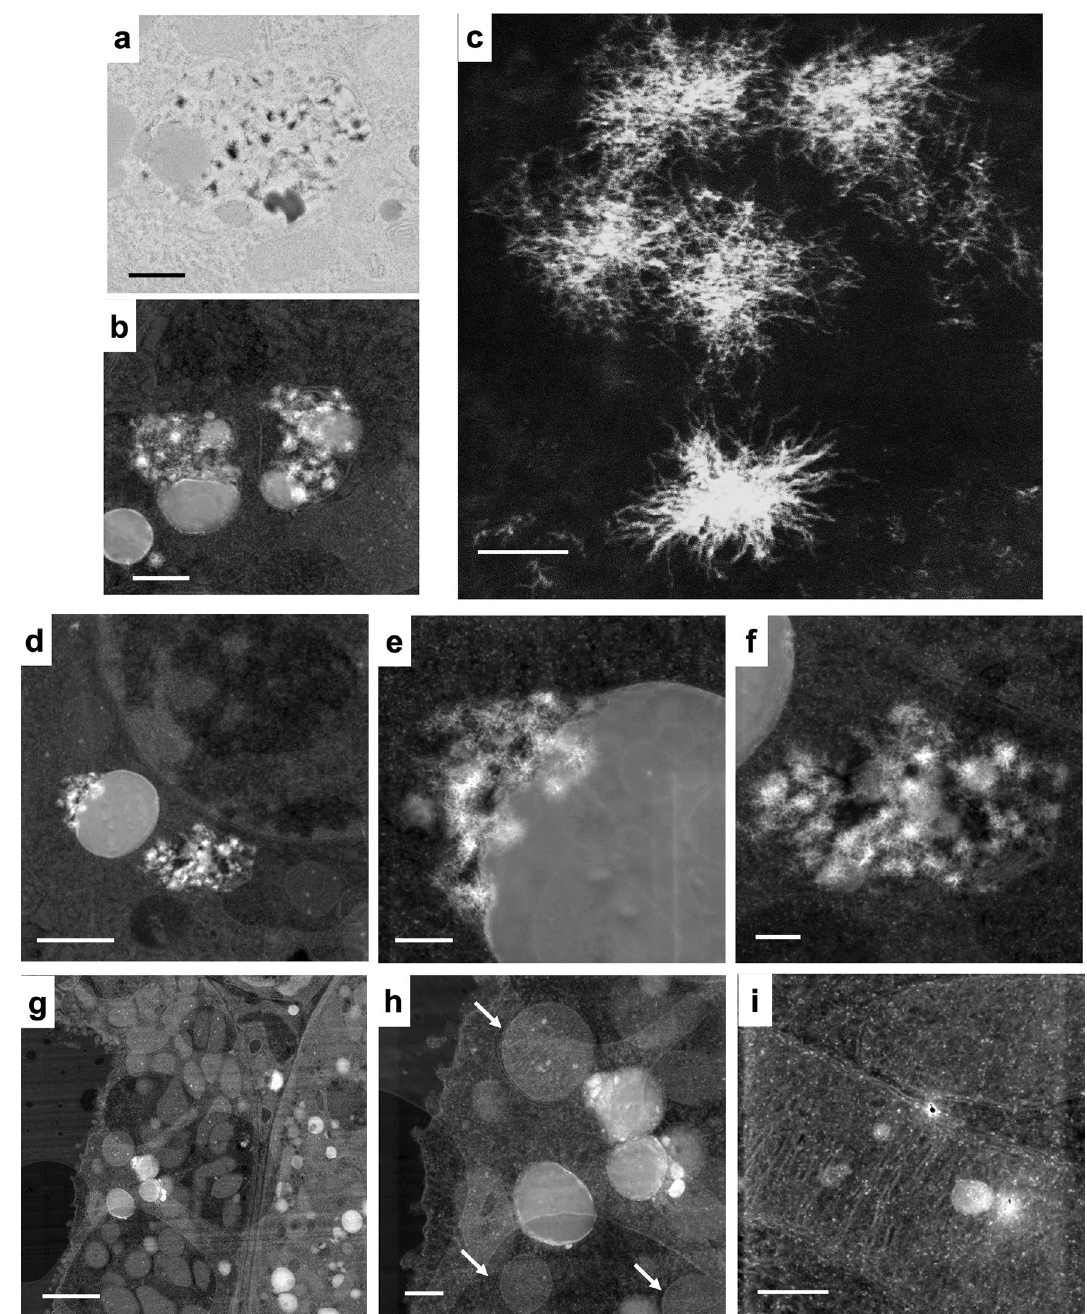
Figure 2. Spiculated electron-dense nanoparticles in the kidney arise from MRI contrast agent treatment. ( a ) Transmission electron micrograph of electron-dense spiculated material in a cytoplasmic vesicle, renal proximal tubule cell, from a MRI contrast agent-treated female. The vacuole also contains unilamellar (lipid) vesicles. Calibration bar = 500 nm. Hitachi H7700 TEM, AMT 16-megapixel digital camera. ( b ) Darkfield scanning transmission electron microscopic image of cytoplasmic vesicles containing lipid droplets with electron-dense nanoparticles from a MRI contrast agent-treated male. Calibration bar = 500 nm. FEI Tecnai G(2) S-Twin (300 kV) transmission electron microscope equipped with an EDAX ECON X-ray detector. ( c ) High magnification of filamented, spiculated, electron-dense nanoparticles in the kidney from a MRI contrast agent-treated male. Scanning transmission electron microscopy. Calibration bar = 50 nm. JEOL 2010F FEGSTEM 200 kV transmission electron microscope with silicon drift detector. ( d ) Peri-nuclear unilamellar vesicle and spiculated nanoparticles in a renal epithelial cell from a MRI contrast agent-treated female. Scanning transmission electron microscopy. Calibration bar = 1 µm. ( e ) Magnification of the area in ( d ). Calibration bar = 200 nm. ( f ) Magnification of electron-dense nanoparticles in ( d ). Scanning transmission electron microscopy. Calibration bar = 200 nm. ( g ) Dark field scanning transmission electron microscopy image of kidney cortex from a MRI contrast agent-treated male. Multiple intracellular unilamellar vesicles, electron-dense material, and mitochondria are visible. Calibration bar = 2 µm. ( h ) Magnification of the region from ( g ) demonstrates rounded mitochondria (arrows) and lipid bodies rimmed with electron-dense material. Calibration bar = 500 nm. ( i ) A mitochondrion in the renal cortex with electron-dense inclusion, from a MRI contrast agent-treated male. Scanning transmission electron microscopy. Calibration bar = 250 nm. ( d – i ), FEI Tecnai G(2) S-Twin (300 kV) transmission electron microscope equipped with an EDAX ECON X-ray